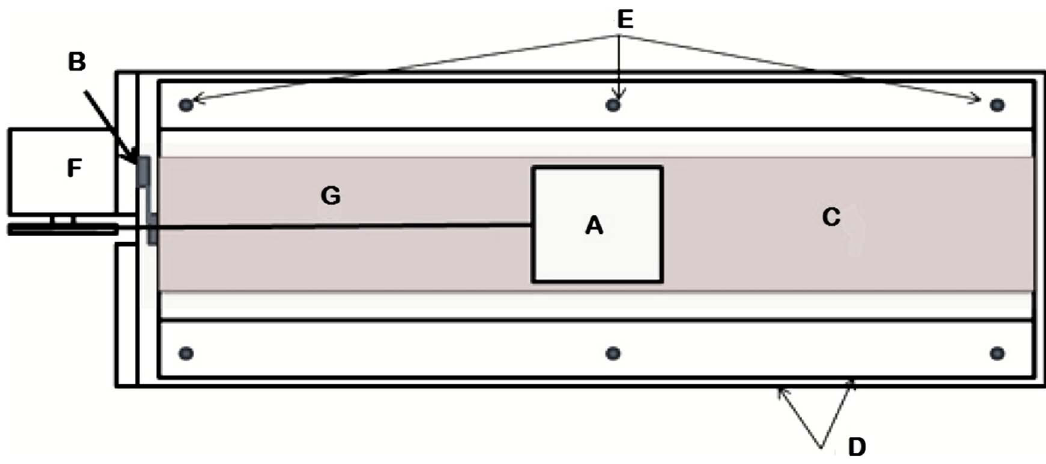
Figure 2. Experimental stick-slip block system with asperities [22] . See text for details.